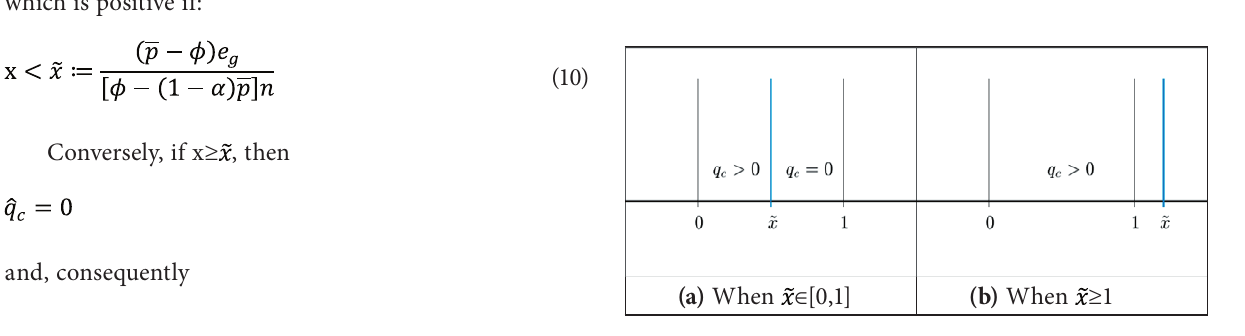
Figure 2. TPC firms’ quantities